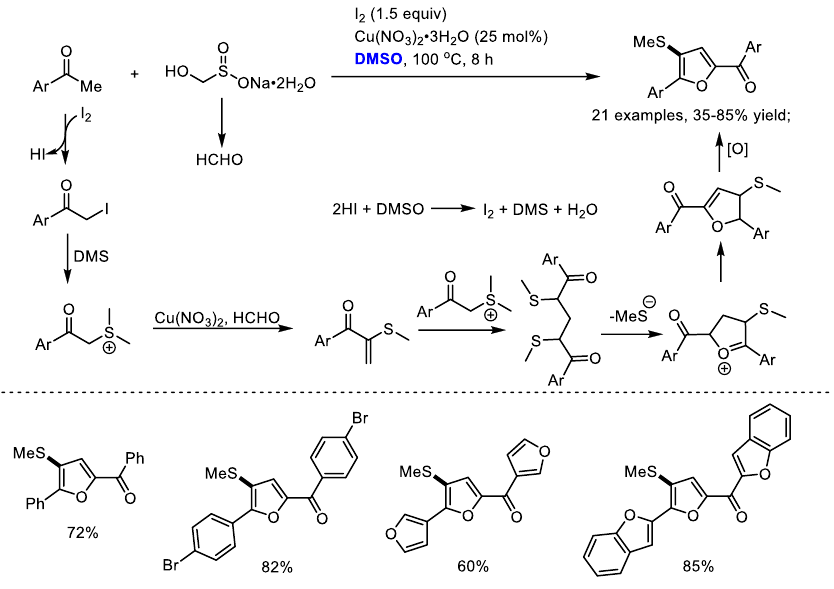
Scheme 22. DMSO/SOCl 2 -promoted synthesis of 3-methylthioindoles